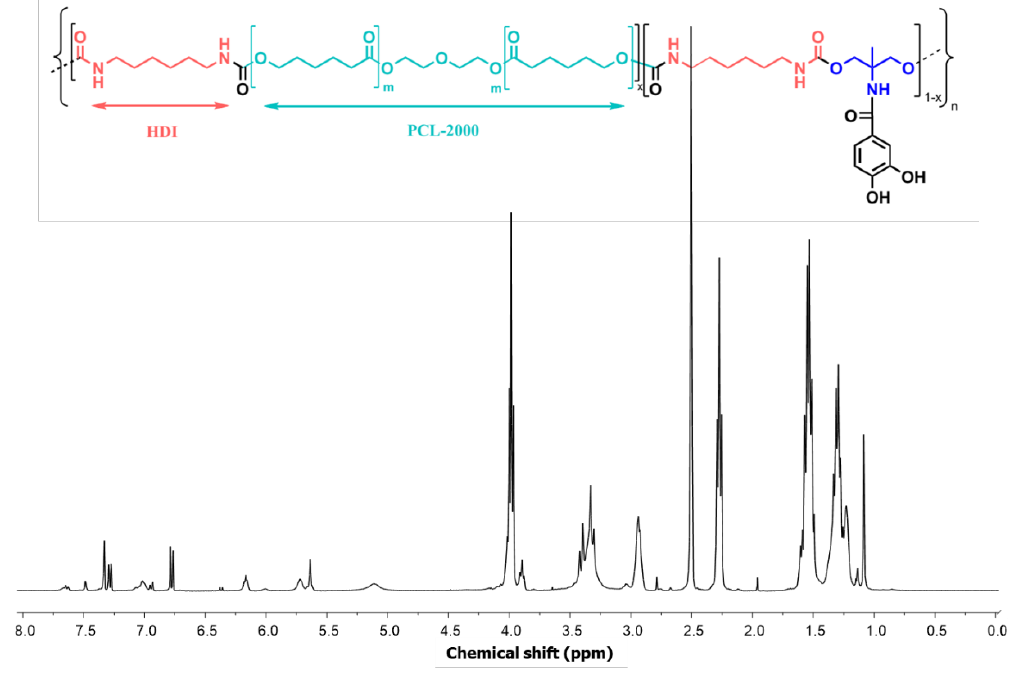
Figure 3. The 1 H-NMR spectrum of PU-Cat-HS 20 in deuterated DMSO.